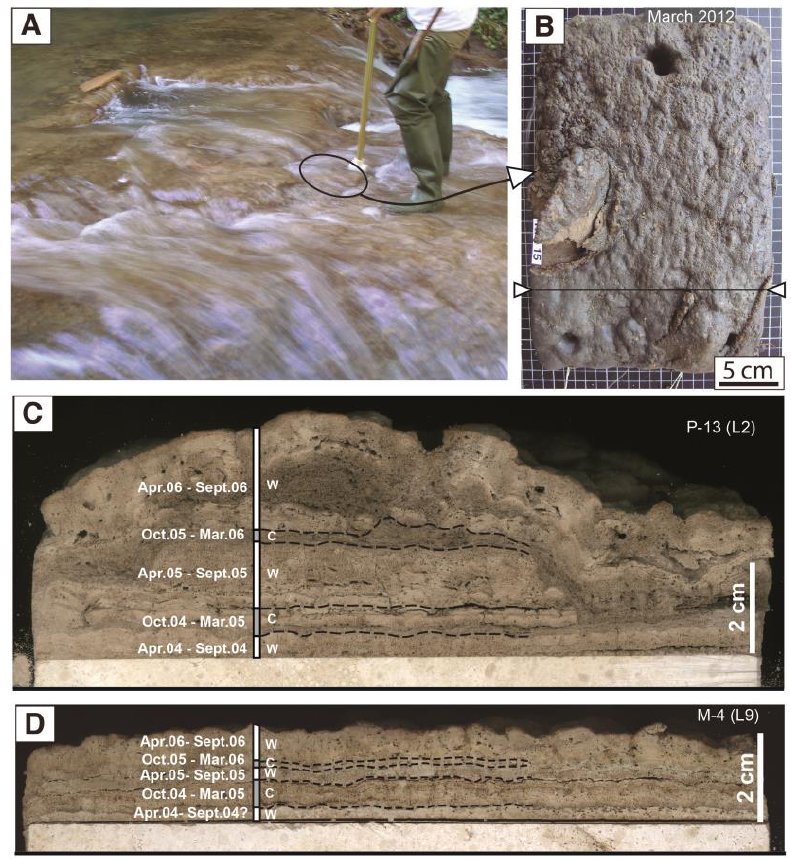
Figure 2. ( A ) Field view of site where Tablet RP-16 was installed in the River Piedra [19]; ( B ) Plan view of Tablet RP-16 once removed from the river. Line indicates position for cutting; ( C , D ) Cross sections of Tablets RP-16 (P-13) and M-4, with sections perpendicular to flow direction. We indicate the thickness of each six-month interval measured at corresponding cutting sections.